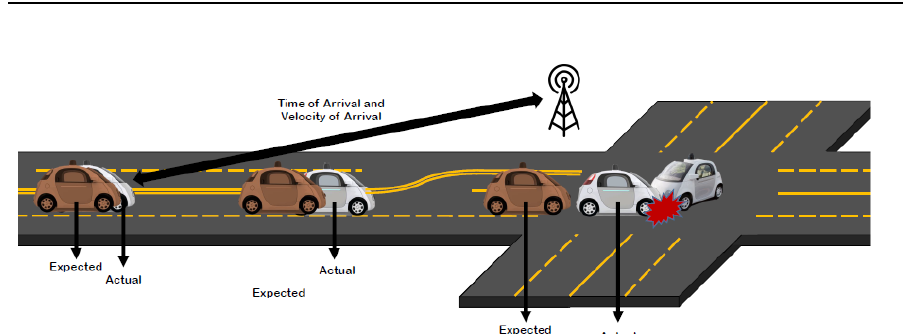
Figure 4. Accident dynamics on IM systems [31].